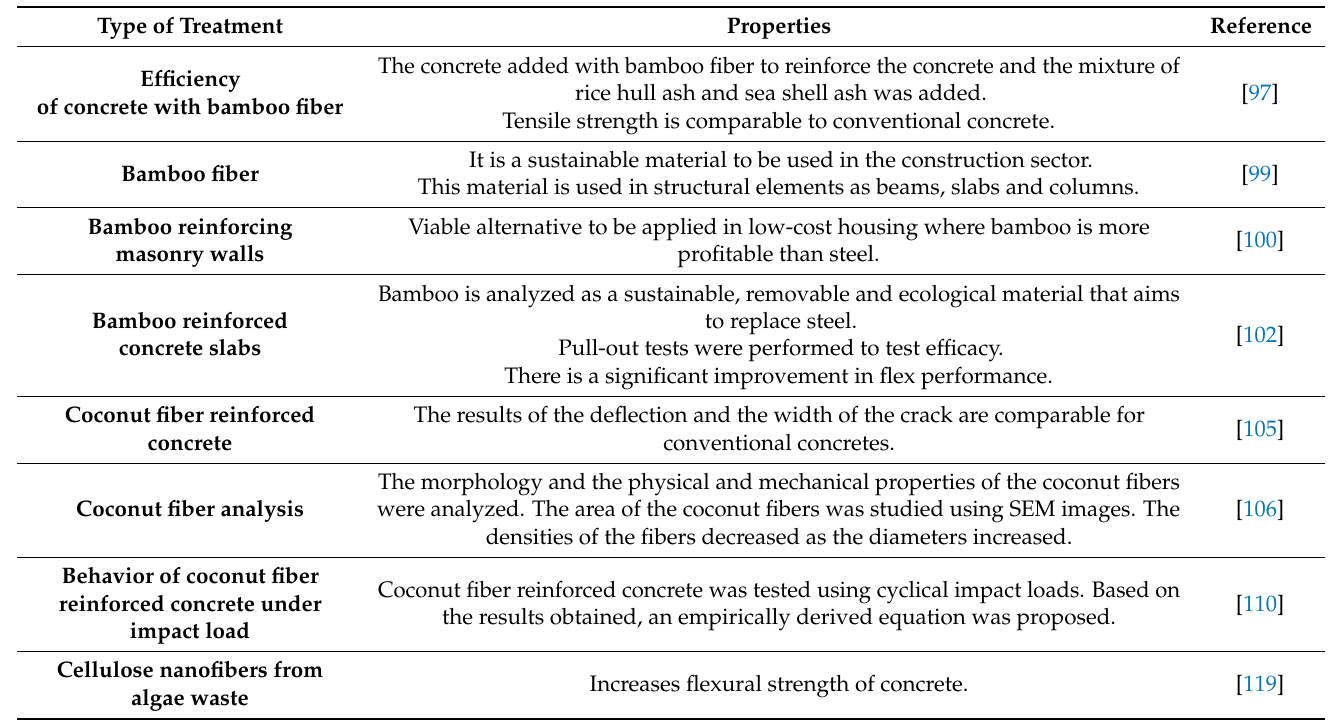
Figure 12. Scheme of procedure to obtain nanocelluse used for improving concrete properties. Reprinted with permission from [122]. Copyright©2019, Elsevier B.V. Table 8. Summary of some treatments with the most significant properties of organic aggregates.